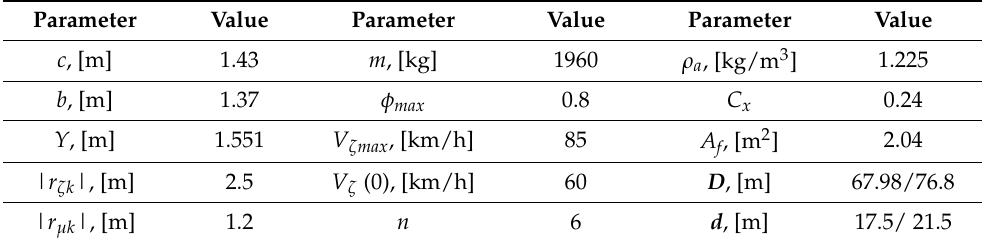
Table 2. Data for simulating the AV motion